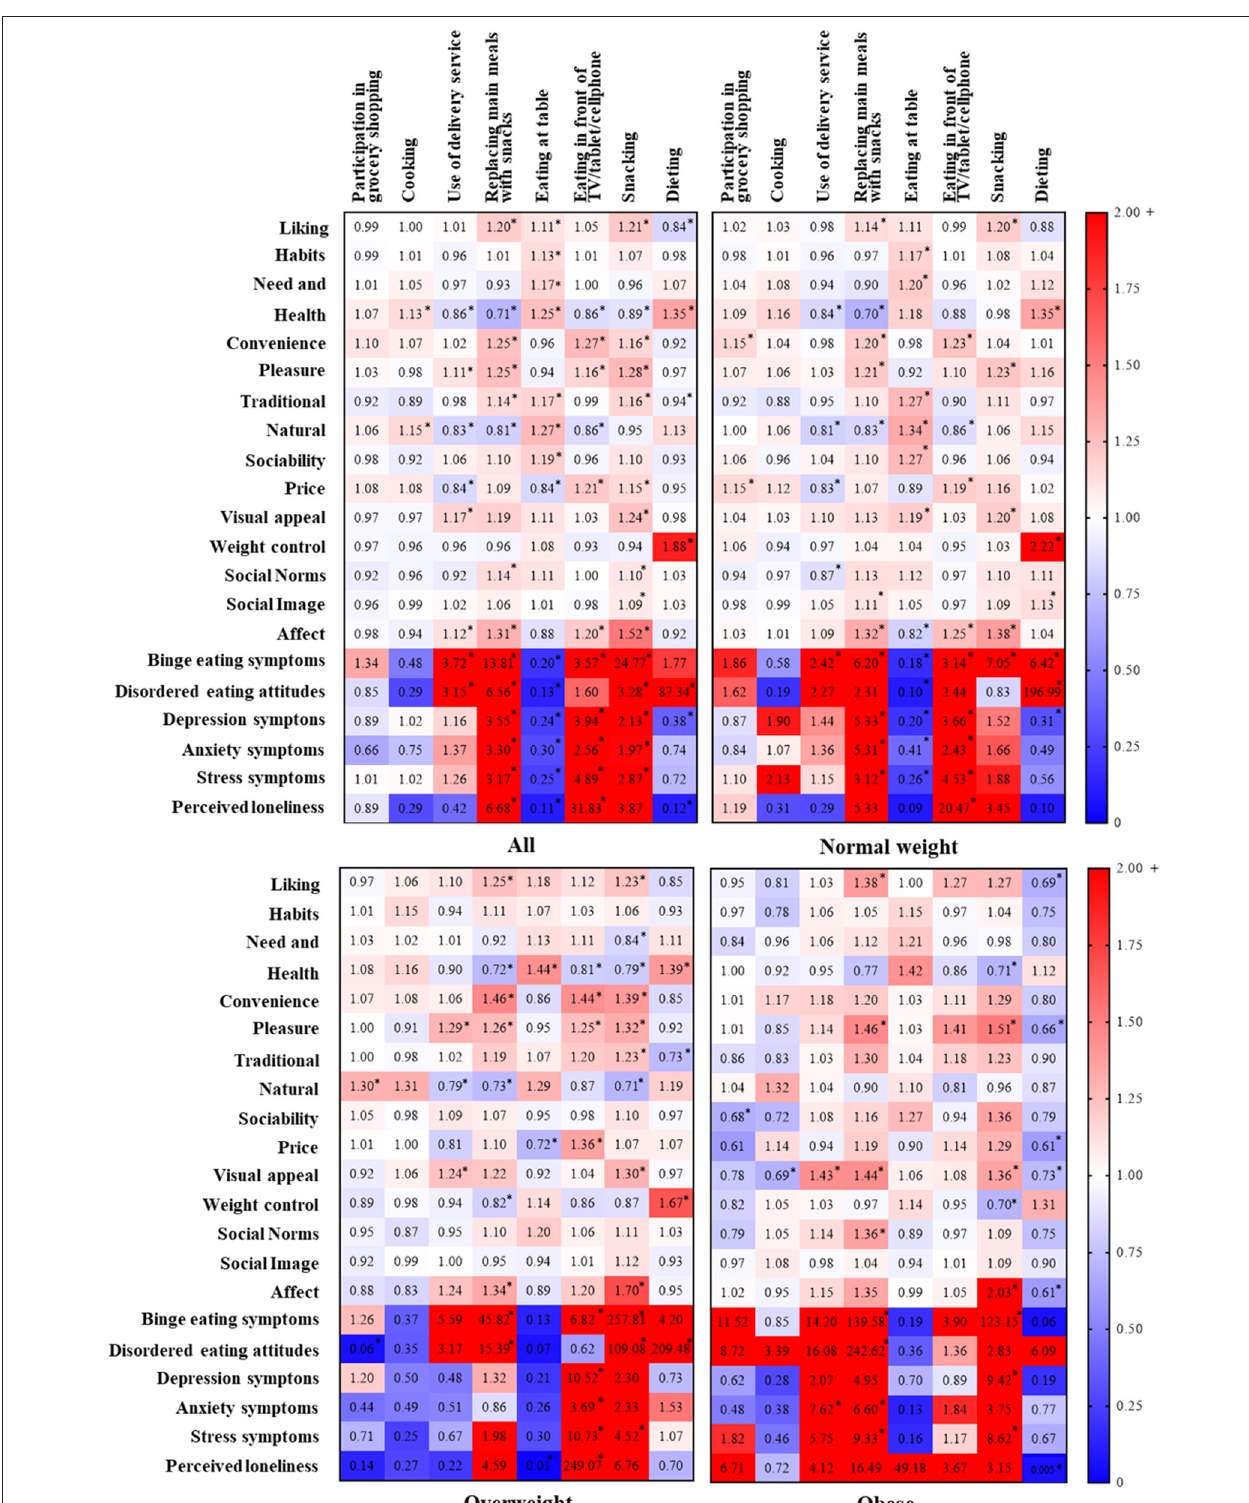
FIGURE 2 | Associations between eating habits, food choice determinants, and psychological symptoms during the COVID-19 quarantine among Brazilian women. Data are presented as as odds ratio (OR). * p < 0.05.